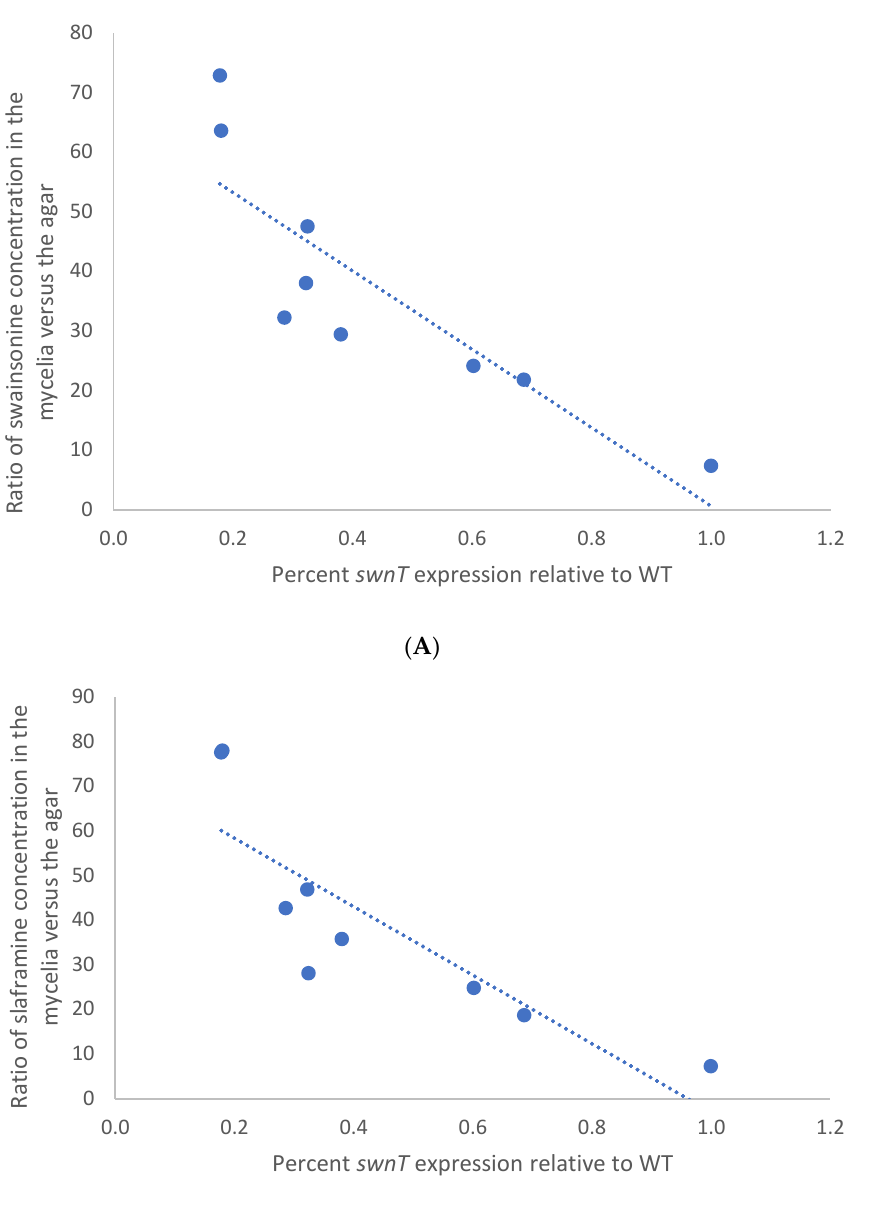
Figure 6. Pearson correlation between percentage of swnT expression relative to WT and ratio of ( A ) swainsonine and ( B ) slaframine concentration in the mycelia versus the agar in the pSilent- swnT transformants and WT. Correlation coefficient was used to determine the relationship between swnT gene expression and the ratio of ( A ) swainsonine (r = −0.86) and ( B ) slaframine (r = −0.85) concentrations in the mycelia versus the agar.